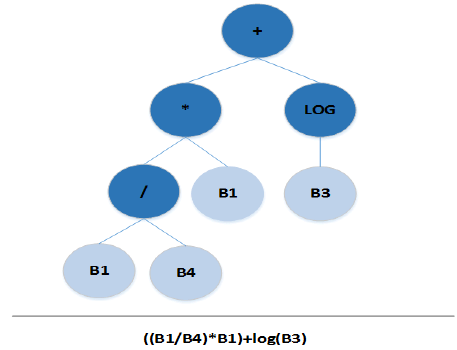
Figure 2. Example of candidate solution represented as hierarchical tree expression (internally) and computer program